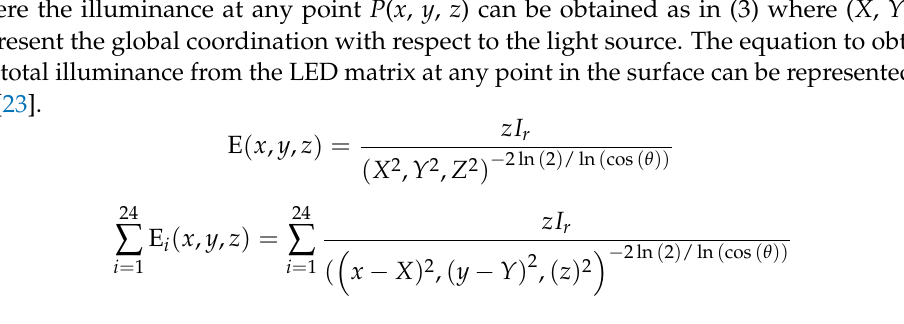
Figure 7. The measured relation between luminance intensity and height.